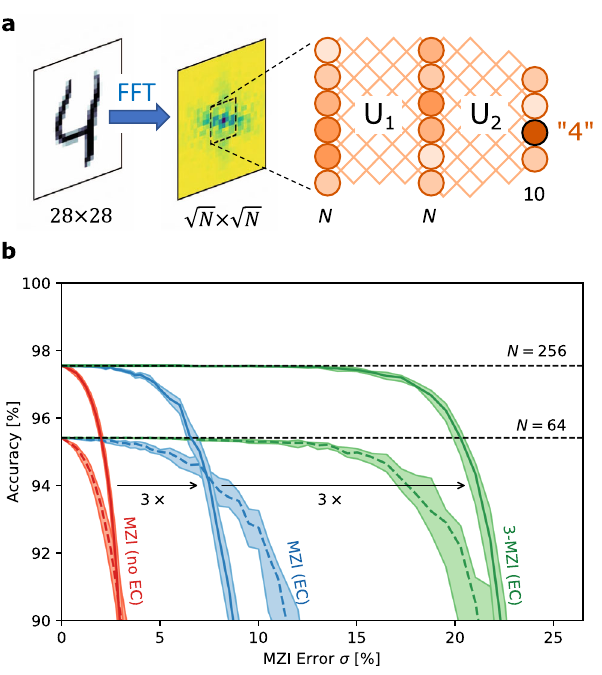
Fig.4|EffectofhardwareerrorsonDNNinference.a Benchmarkneuralnetwork consisting of FFT preprocessing, windowing,and twoDNNlayers, wherethe linear connections U 1 and U 2 are realized with MZI meshes 17,39 . b Inference accuracy as a function of MZI error.